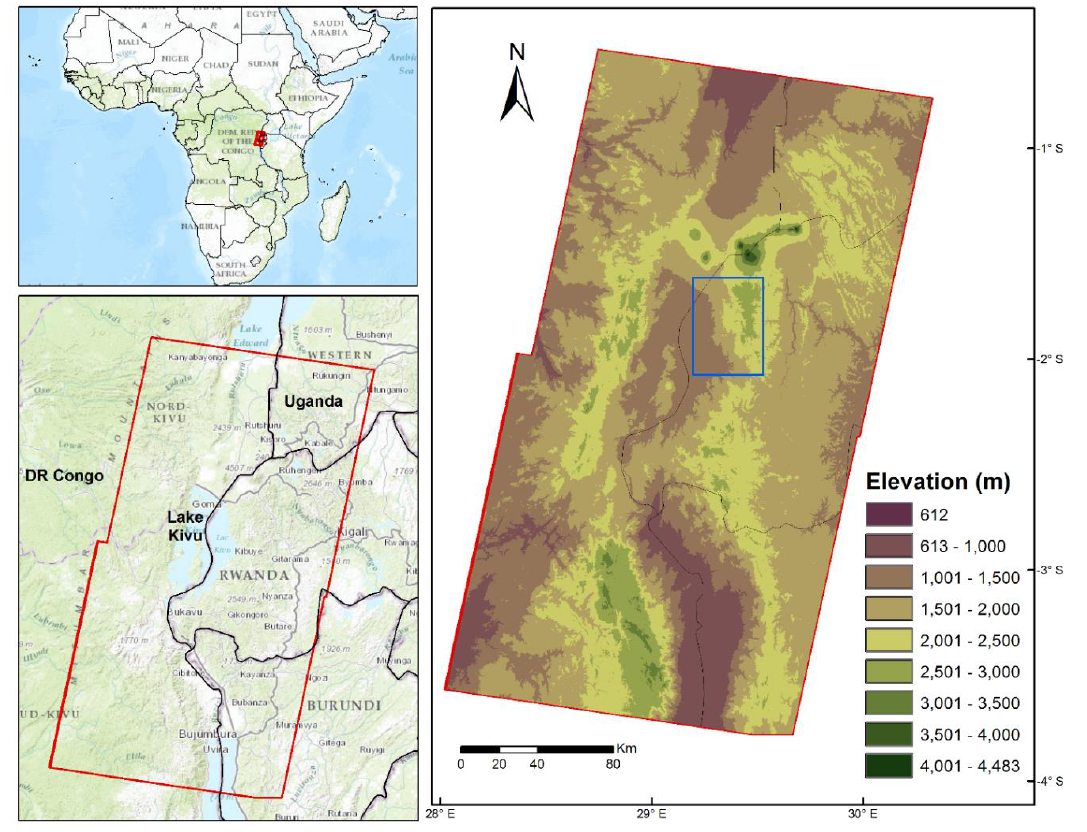
Figure 1. Location of the study area covered by two Landsat scenes: south and north (the red rectangle).